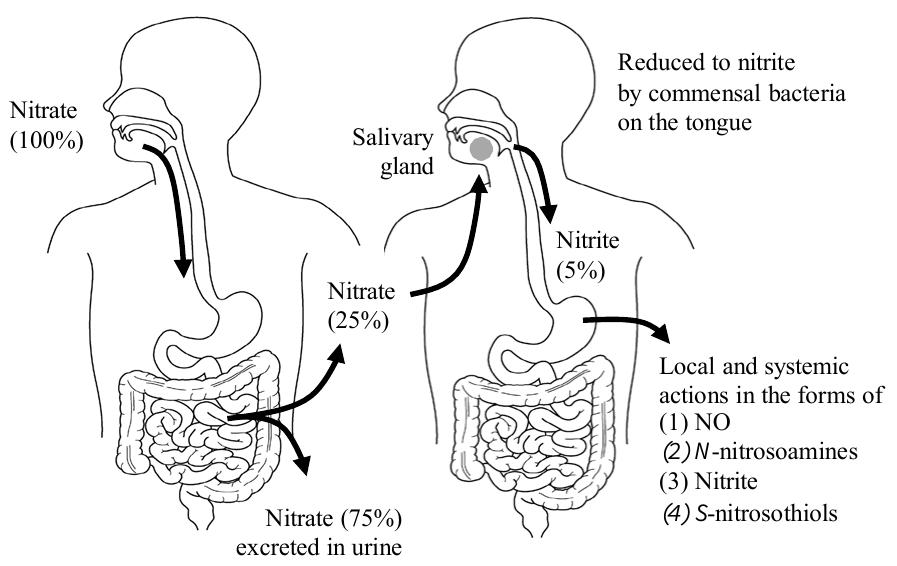
Figure 2. The entero-salivary nitrate-nitrite-NO pathway. Twenty-five percent of the ingested dietary nitrate is recycled to the saliva, and 20% of the nitrate in saliva is converted to nitrite by oral commensal bacteria. Approximately 5% of the originally ingested nitrate is swallowed into the stomach, and provides for NO activities in various forms. (1) NO for local vasodilation, mucus formation, and antimicrobial activity; (2) N -nitrosoamines for local carcinogenesis; (3) Nitrite for nitrite pool and transnitrosylation in the peripheral tissues; (4) S -nitrosothiols for transnitrosylation in the peripheral